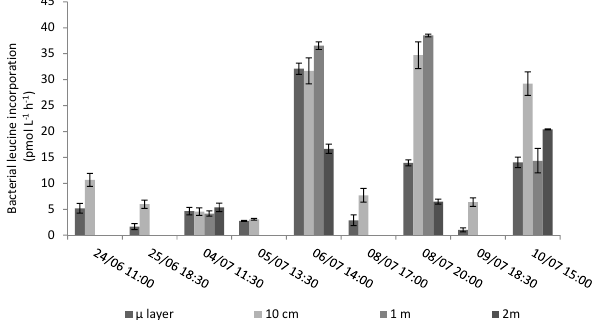
Fig. 3. Variability in bacterial leucine incorporation for microlayer, 10cm, 1 and 2m depths, where error bars denote ± 1 sd based on three replicates.